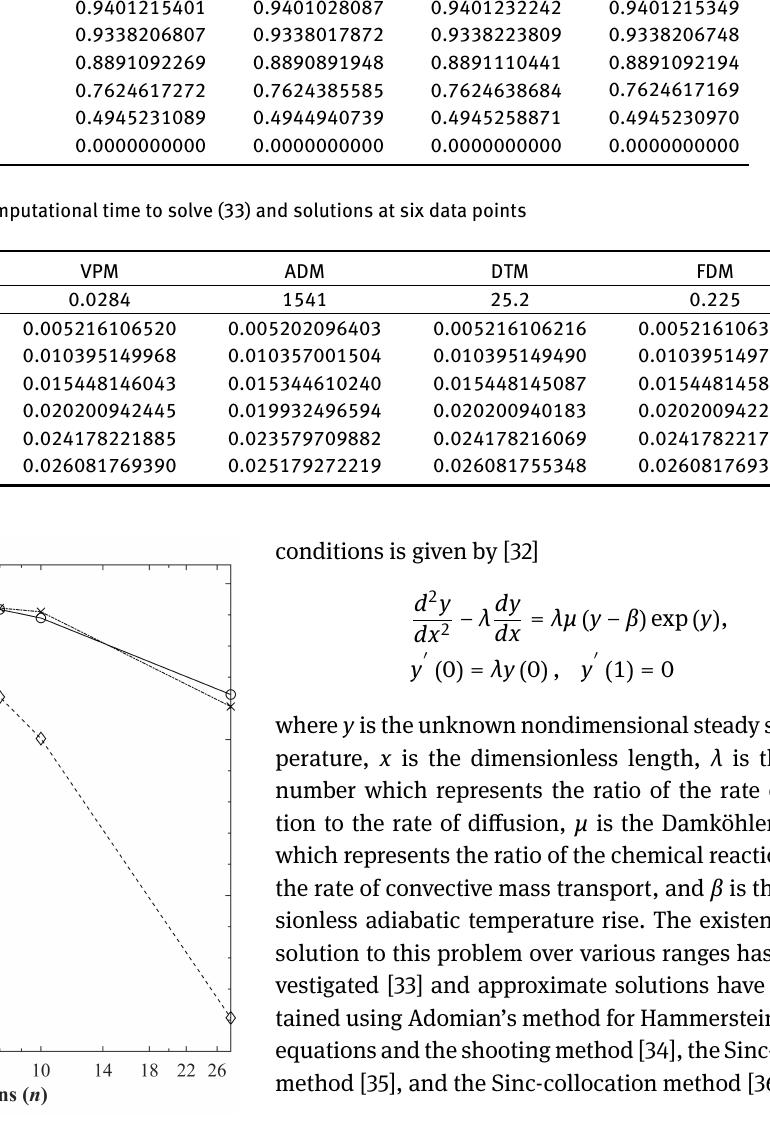
Fig. 3: Comparison of the average error remainder as a function of iteration for the approximate solutions of equation (26) using VPM, ADM, and